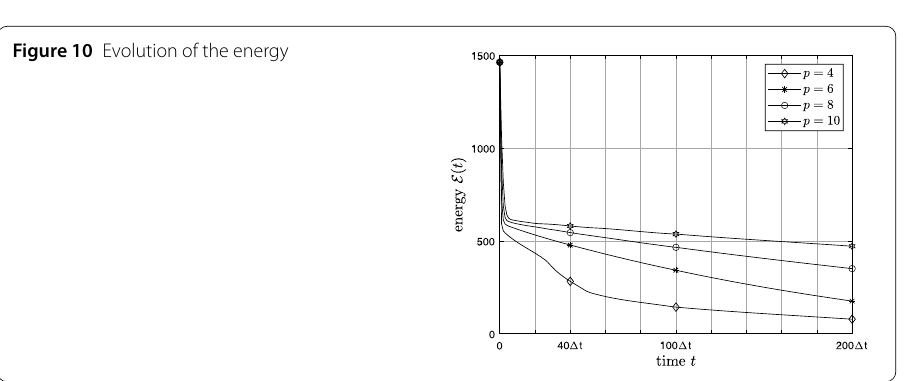
Figure 10 Evolution of the